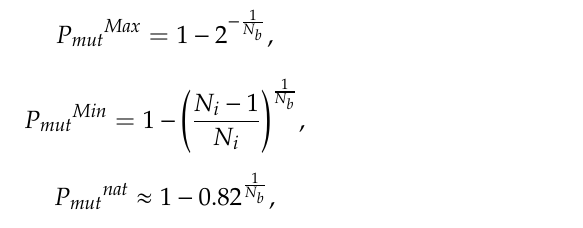
Figure 2. Integer population size against total bits for total bits selection.